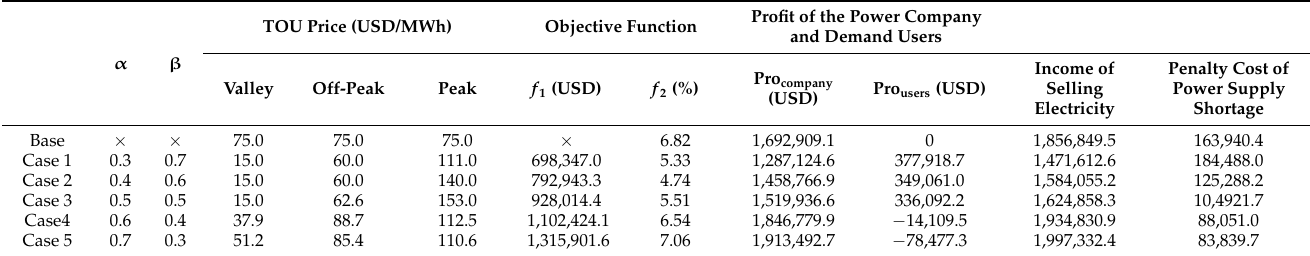
Table 6. Simulation results of five cases.